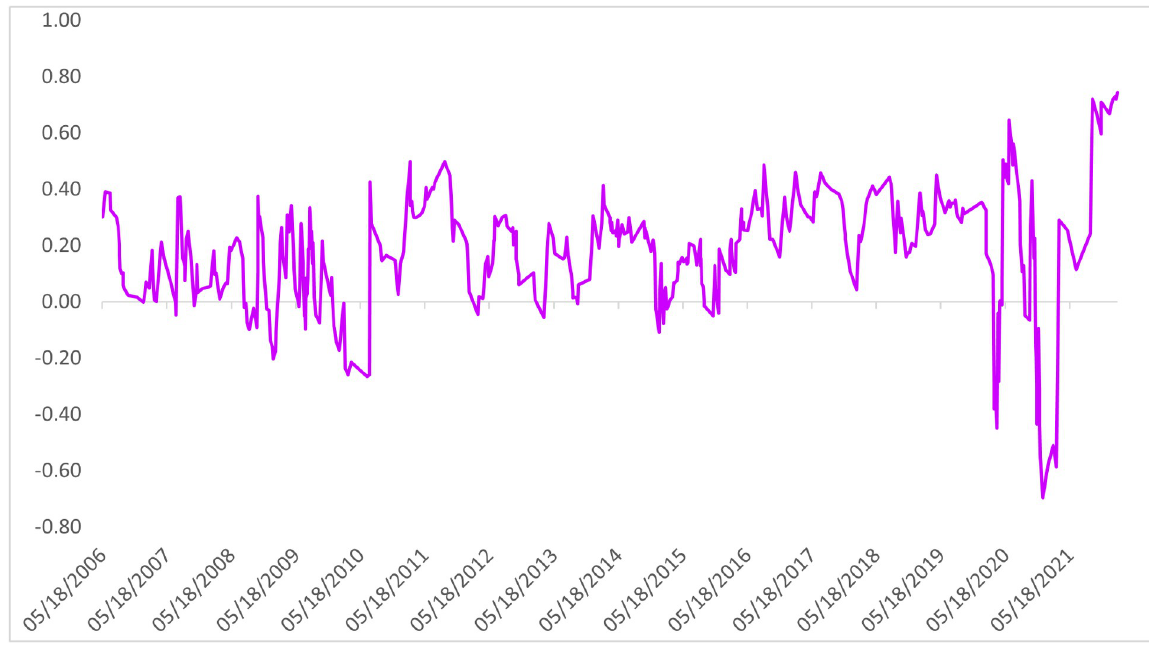
Fig 5. Time–varying conditional correlation between beef and